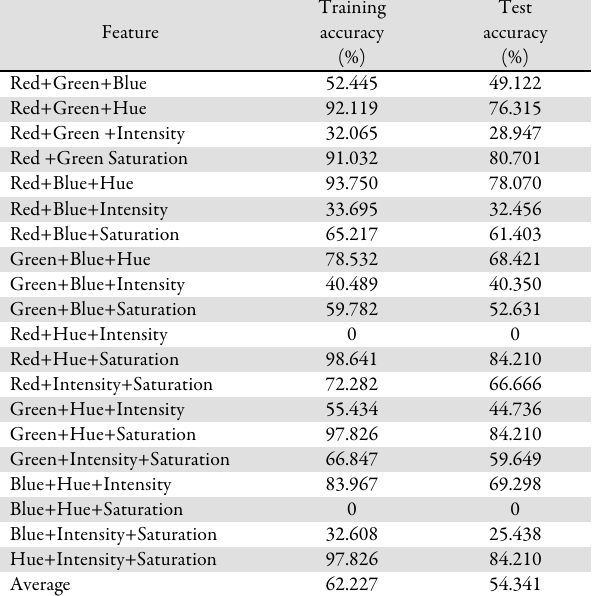
Table 4. Accuracy values using three colour features